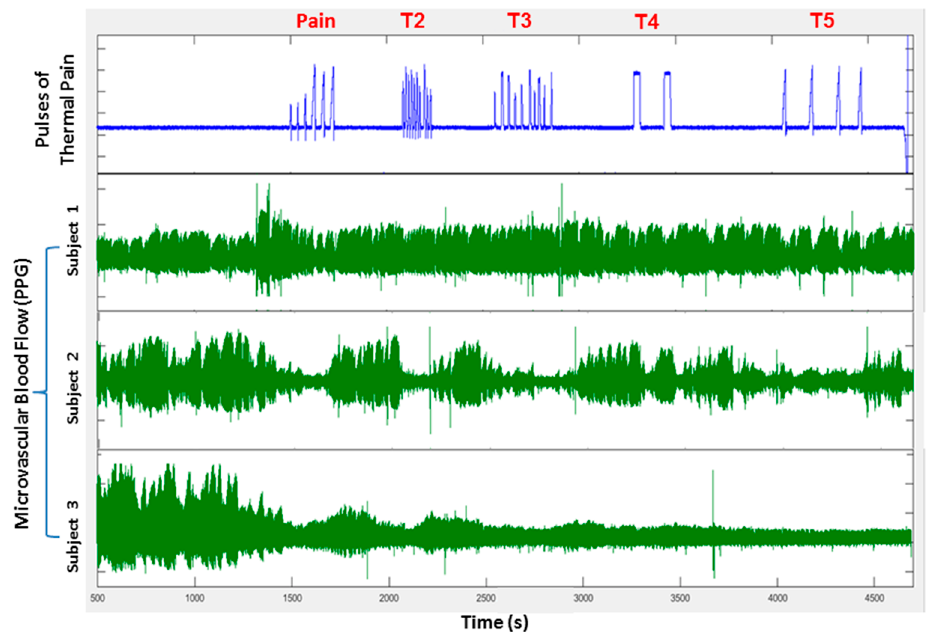
Figure 4. Microvascular blood flow patterns recorded in three subjects in response to several sequences of painful heat pulses (pain, T2–T5) demonstrate significant subject-to-subject variability in neural-mediated vasoconstriction responses. (1) Subject 1 vasoconstricts and recovers blood flow between individual pain pulses; (2) Subject 2 has prolonged vasoconstriction with every sequence of pain stimuli, but recovers blood flow between the sequences; and (3) Subject 3 remains vasoconstricted after the initial stimulus with poor blood flow recovery.